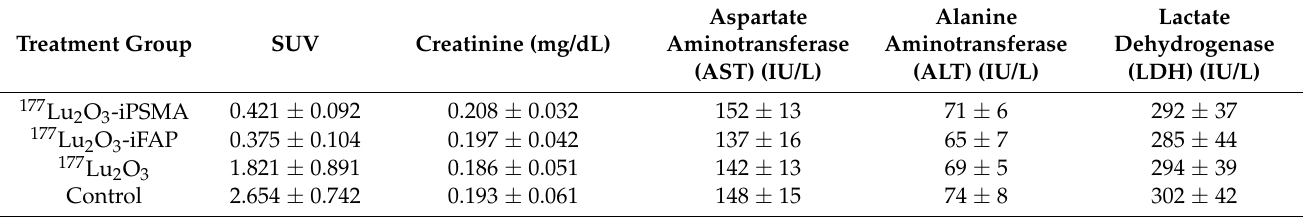
Table 6. Tumor metabolic activity ([ 18 F]FDG/micro-PET; SUV(standard uptake value)), creatinine, aspartate aminotransferase (AST), alanine aminotransferase (ALT), and lactate dehydrogenase (LDH) serum concentrations in mice bearing HCT116 tumors after 21 days of treatment with 177 Lu 2 O 3 - iPSMA, 177 Lu 2 O 3 -iFAP, or 177 Lu 2 O 3 nanoparticles (mean ± standard